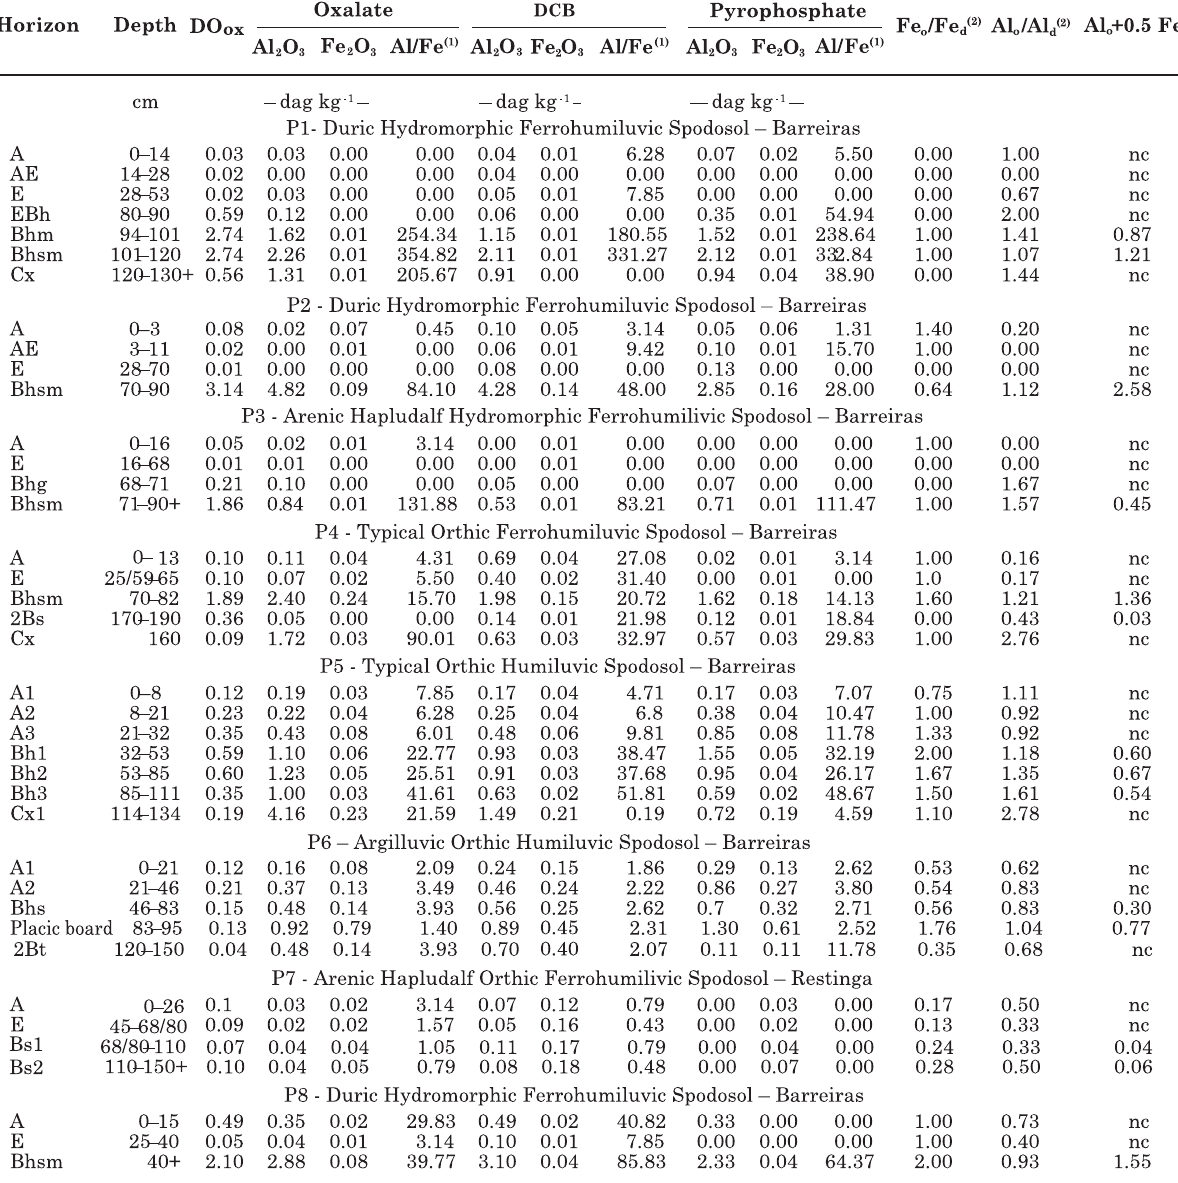
Table 4. Optical density of the extract of ammonium oxalate (DOox), levels of Fe and Al oxides extractable with dithionite-citrate-bicarbonate (DCB), ammonium oxalate and sodium pyrophosphate and ratios between these metals to